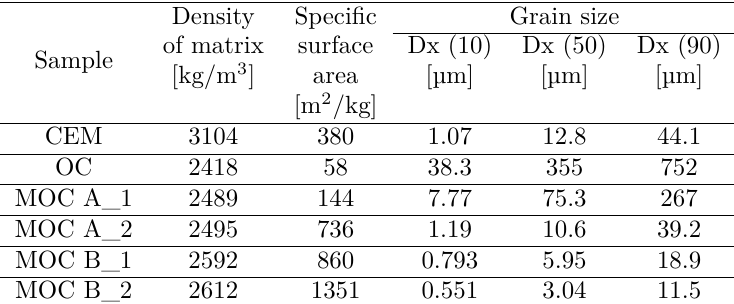
Table 1. Characterization of grains of used materials.